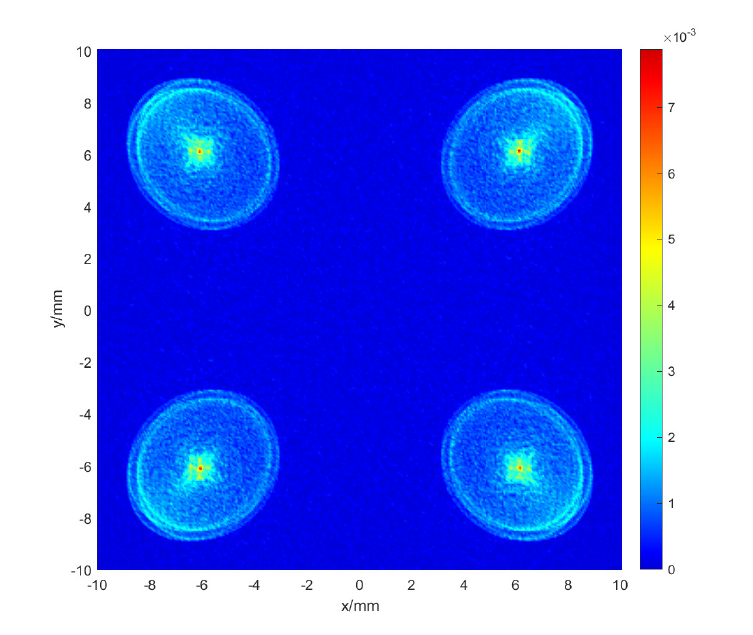
Figure 4. Image spot pattern at the receiver.